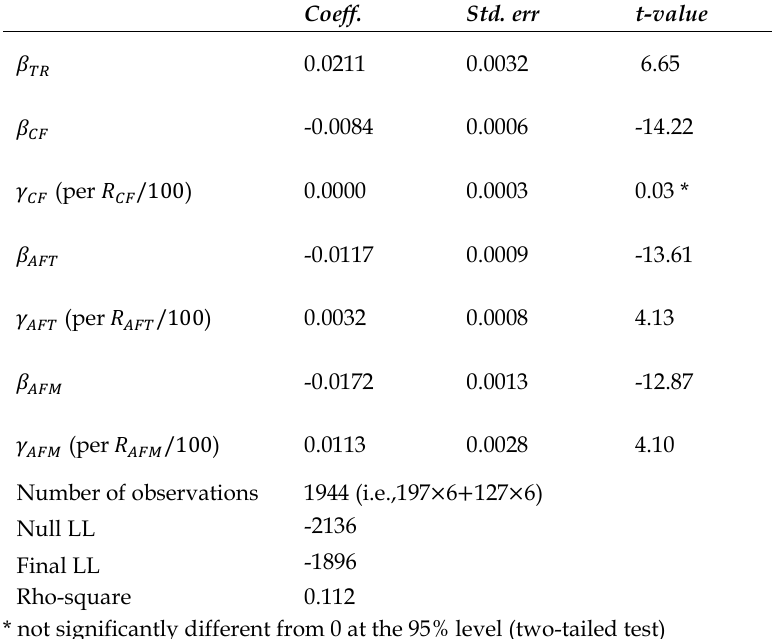
Estimation results of the reference-point model, subsample of participants